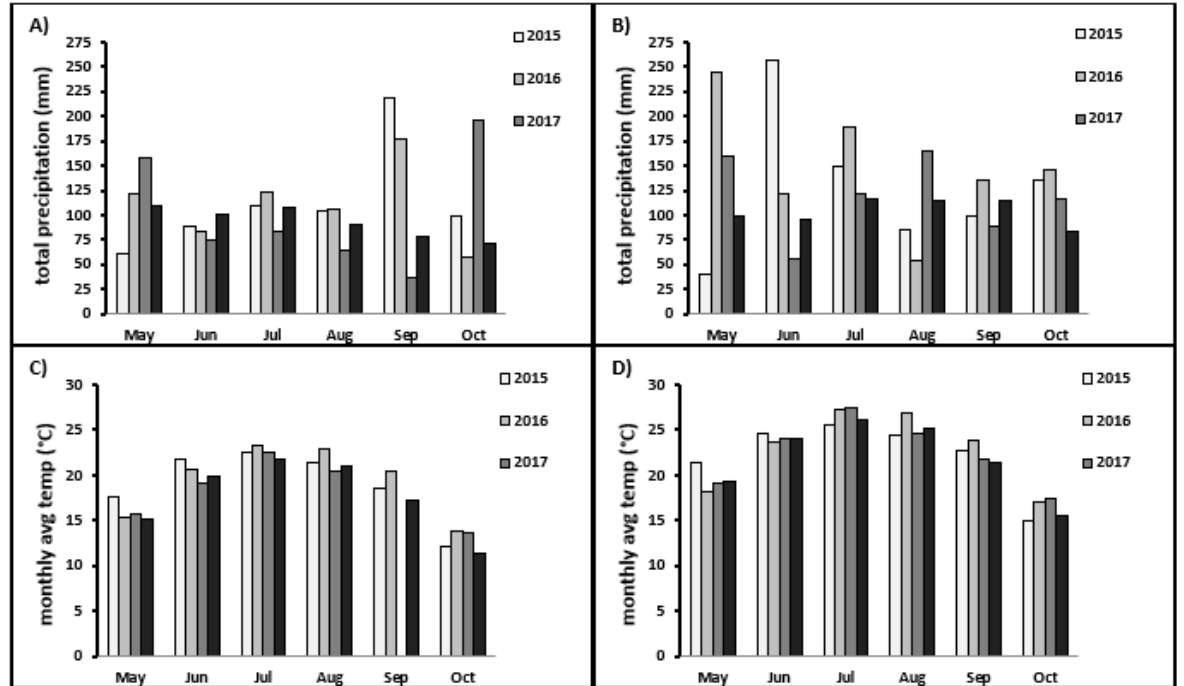
Figure 2. Total monthly and 30-year monthly averages rainfall (mm), and air temperatures (°C) from May through October during the period 2015–2017 in Blacksburg ( A , C ) and New Kent ( B , D ), VA, respectively. Source: National Oceanic and Atmospheric Administration, National Centers for Environmental Information (https://www.ncdc.noaa.gov/cdo-web/search).